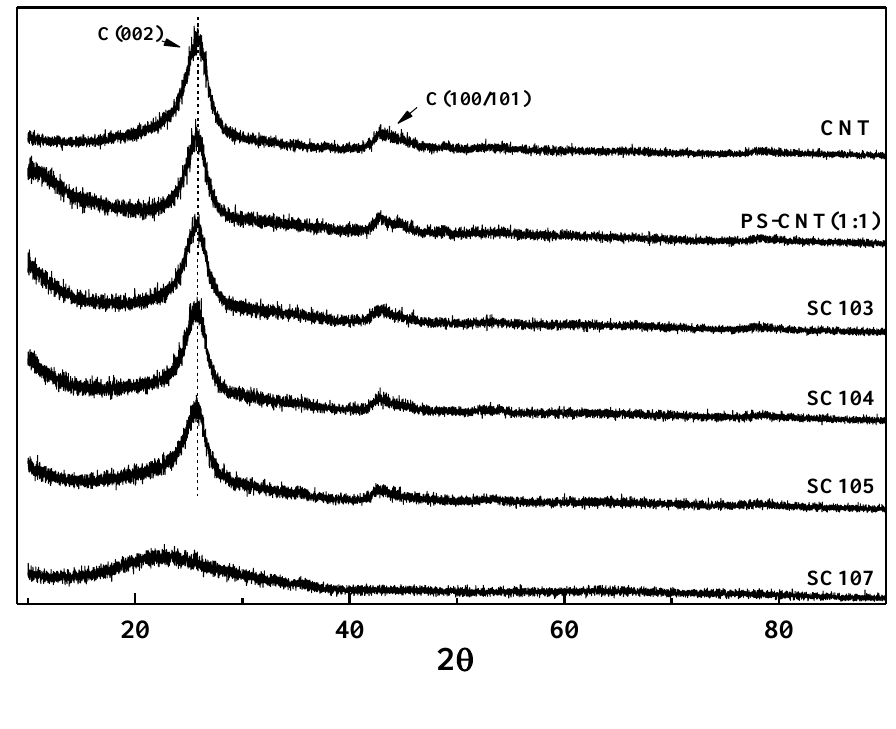
-CNT according to treatment x